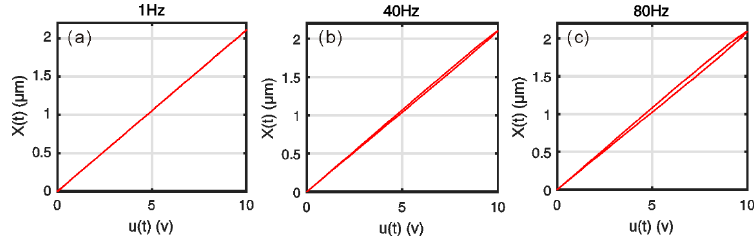
Figure 3. Variations of the component () ht under ( ) 5sin(2 ) 5 u t ft π= + : ( a ) f = 10 Hz; ( b ) f = 40 Hz; ( c ) f = 80 Hz.